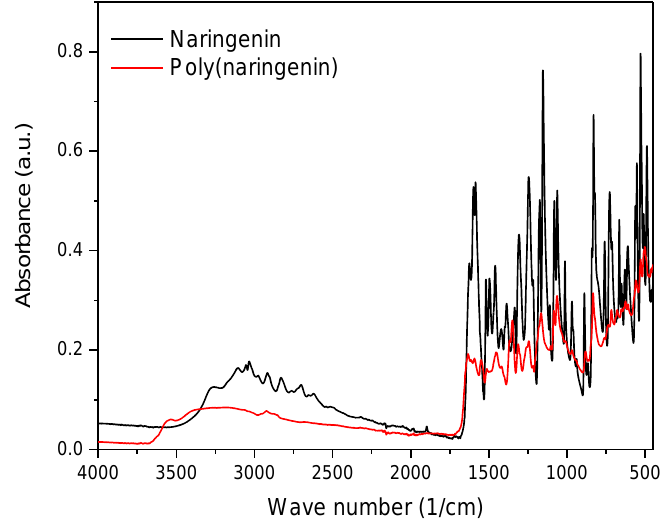
Figure 5. FTIR spectra of naringenin and poly(naringenin).